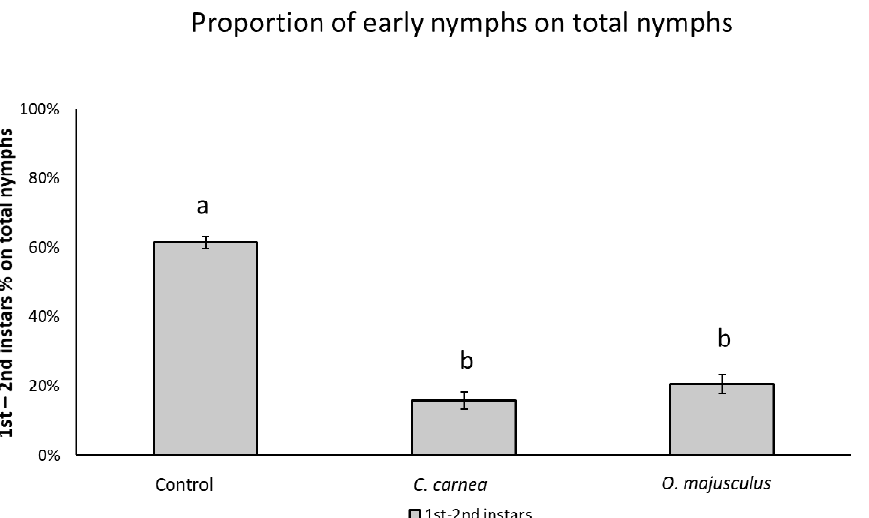
Figure 5. Proportion of Erasmoneura vulnerata 1st–2nd instar nymphs over the total number of nymphs observed at the end of the semi-field experiment (2), in the three treatments ( Chrysoperla carnea , Orius majusculus , and Control) two weeks after predator releases. The percentage (mean ± SE) was calculated as 1st–2nd instar nymphs over of the final number of nymphs. Different letters indicate significant differences at Tukey’s test ( p = 0.05).